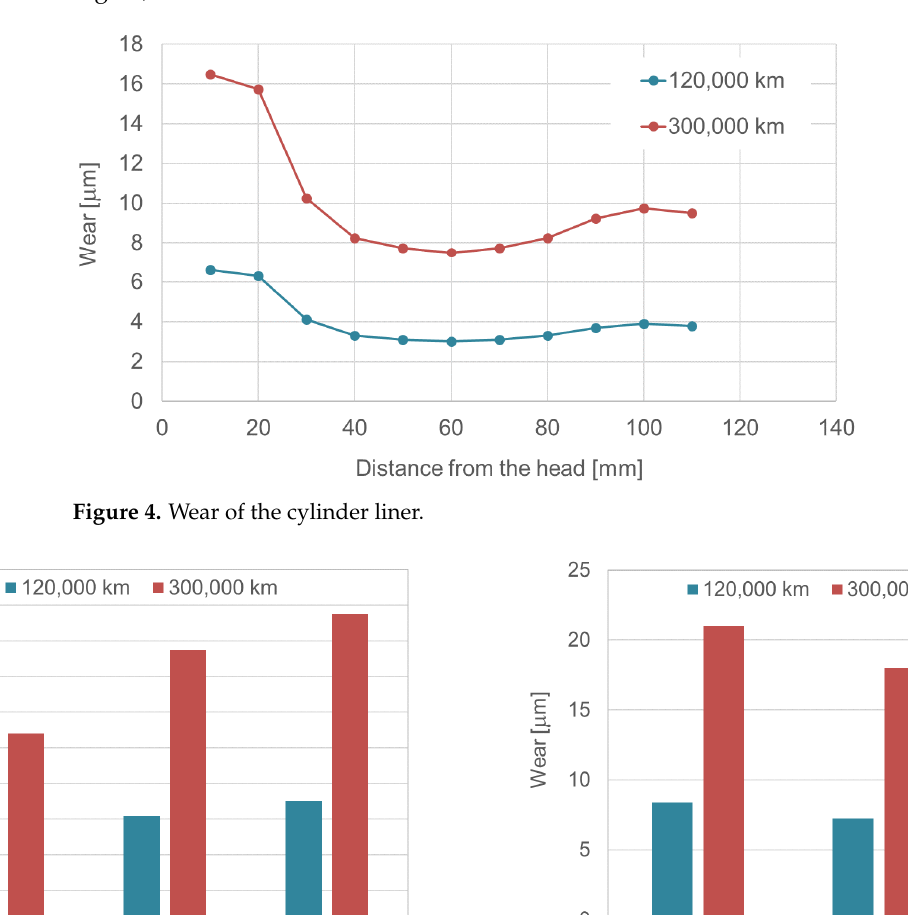
Figure 5. Wear of the rings: ( a ) increase in the ring end gaps; ( b ) changes in the ring heights.